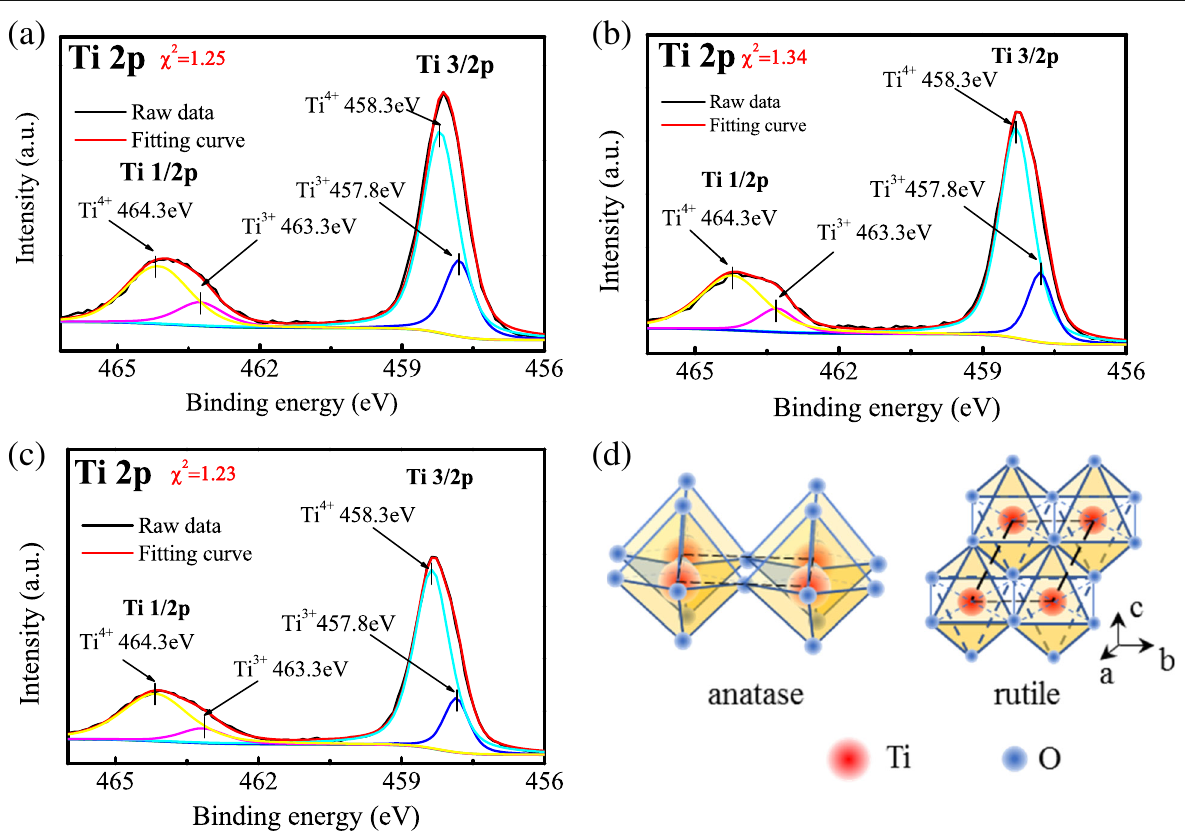
Fig. 9 XPS spectra of a H@TNAs-2, b H@TNAs-3 and c H@TNAs-4. d Sketches of the crystal structure of anatase and rutile [37,